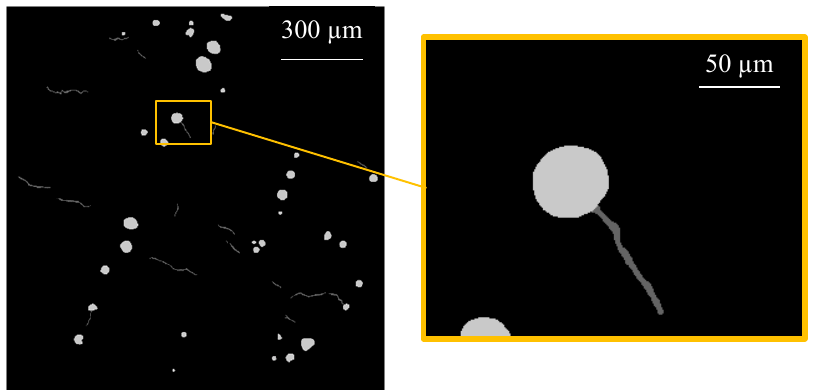
Figure 8. The 256 × 256 patches used as training set (number of patches: 64).